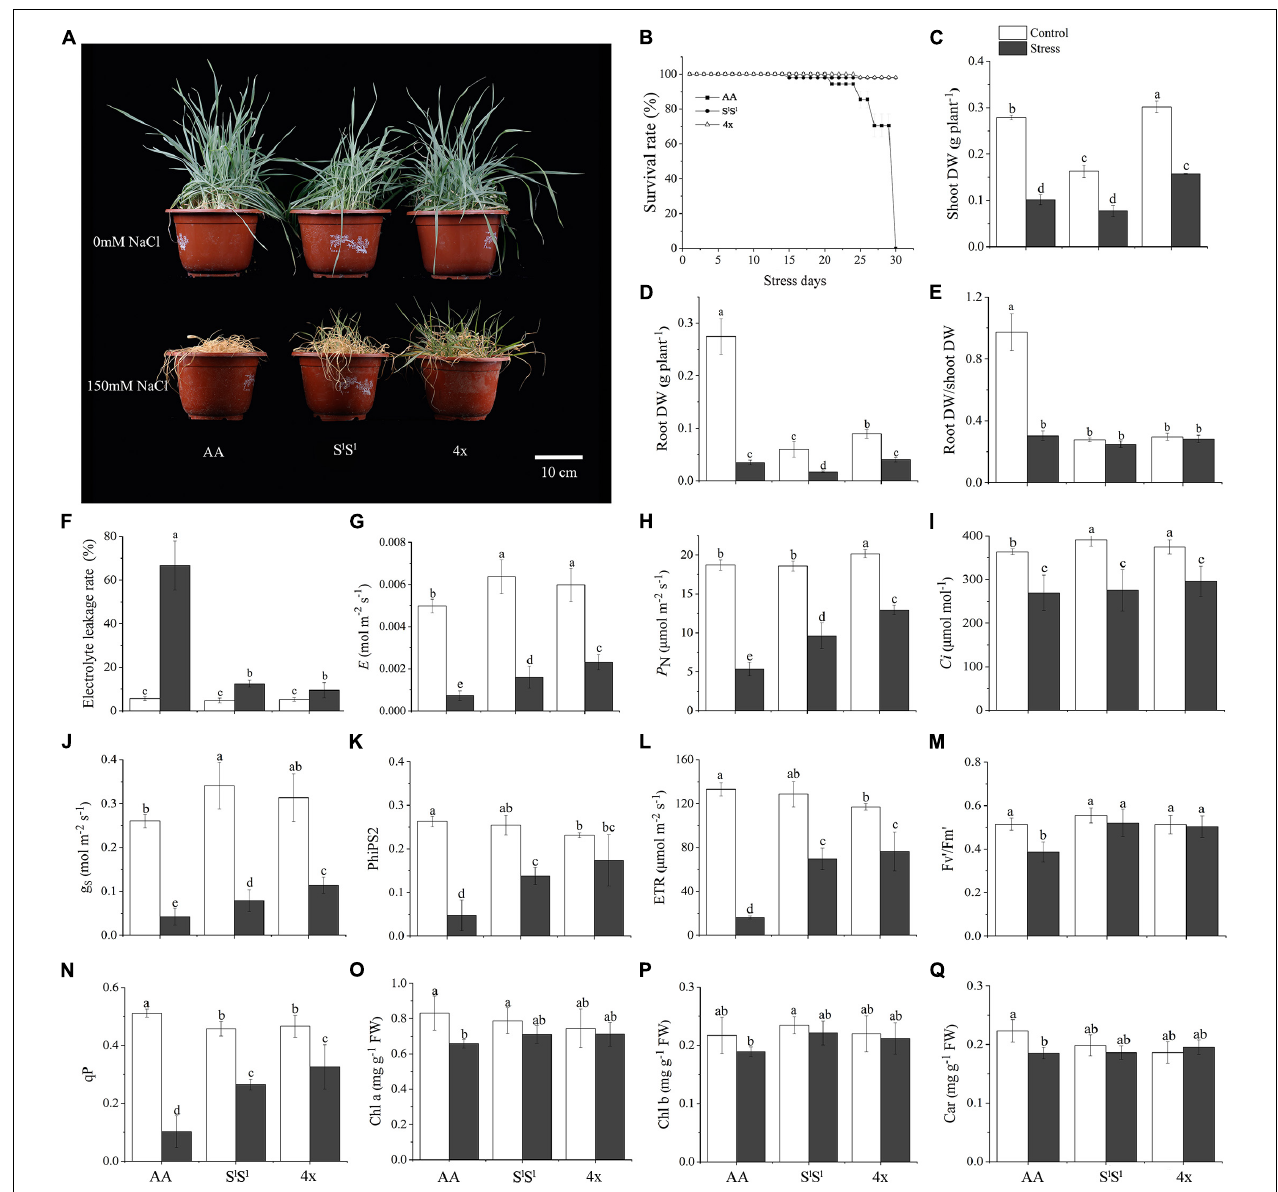
FIGURE 1 | Effects of salinity stress on growth and photosynthesis in a synthetic tetraploid wheat line and its diploid parents. The synthetic tetraploid wheat line (genome S l S l AA, labeled as 4x) was generated by crossing and chromosome-doubling of Triticum urartu (AA genome, labeled as AA) and Aegilops longissima (genome S l S l , labeled as S l S l ). The seedlings were exposed to 150 mM NaCl for 7 (C–Q) and 30 (A,B) days. The values are the mean ( ± SD) of three biological replicates. Different letters above the bar showed significant differences among wheat lines and treatments according to t -test ( P < 0.05). Fv/Fm, maximum quantum efficiency of photosystem II; Fv (cid:48) /Fm (cid:48) , effective quantum efficiency of PSII; PhiPS2, real quantum efficiency of PSII; qP, photochemical quenching; P N , net photosynthetic rate, g s , stomatal conductance, Ci, intercellular CO2 concentration, E , transpiration rate; ETR, electron transport rate; Chl, chlorophyll; Car,